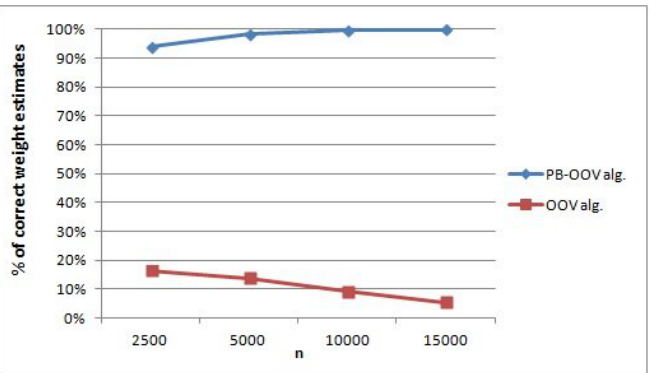
Figure 13. Percentage of correct weights estimates based on acceptance rates using the PB distribution and OOV approximation respectively, for n = 2500, 5000, 10,000 and